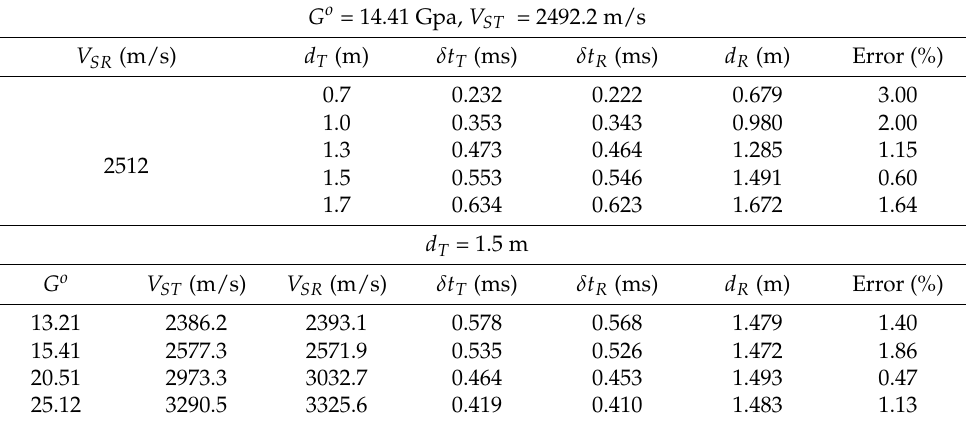
Table 2. Inversion results of interface